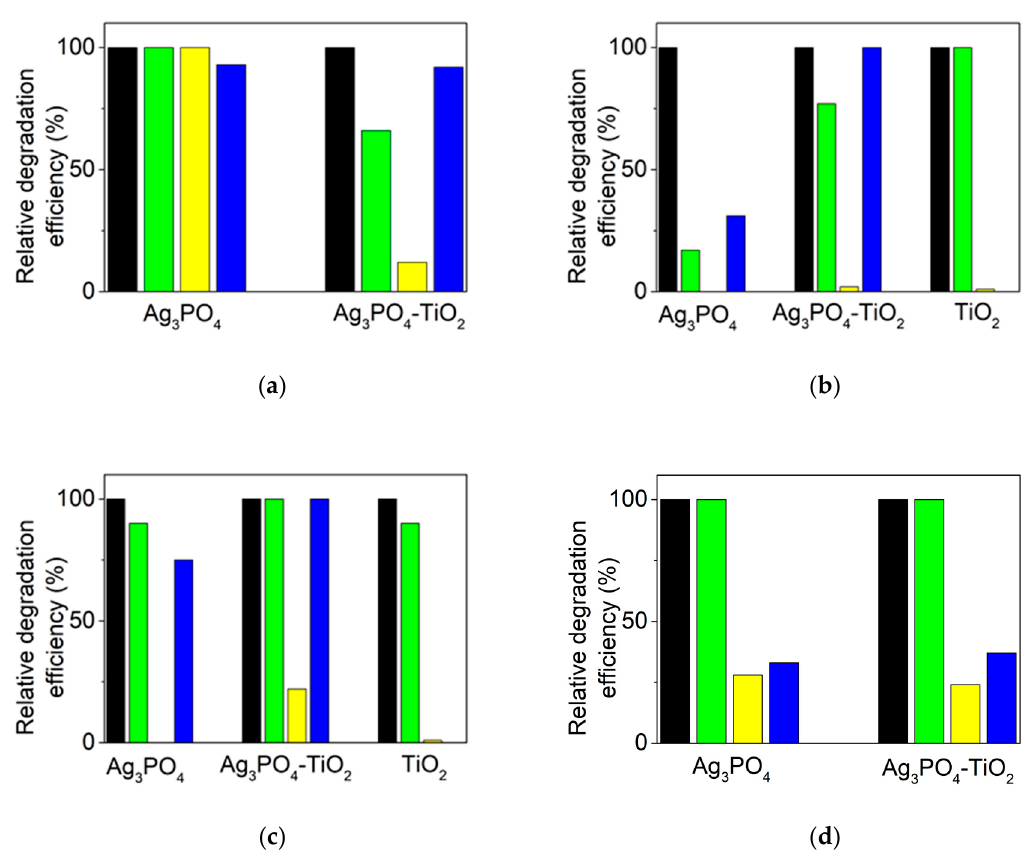
Figure 7. Effect of different scavengers on the relative degradation efficiency of TZ ( a ), OII ( b ), RhB ( c ), and BB ( d ) in the presence of Ag 3 PO 4 , hybrid Ag 3 PO 4 –TiO 2 , and TiO 2 , under 450 nm irradiation. No scavenger is shown in black, 2-propanol (1 × 10 − 1 M) is shown in green, p -benzoquinone (1 × 10 − 4 M) is shown in yellow, and ammonium oxalate (1 × 10 − 4 M) is shown in blue. Initial concentrations: 5 × 10 − 5 M (dye) and 0.5 g/L (photocatalyst) in aerated aqueous media. Note that ammonium oxalate was not employed for TiO 2 .